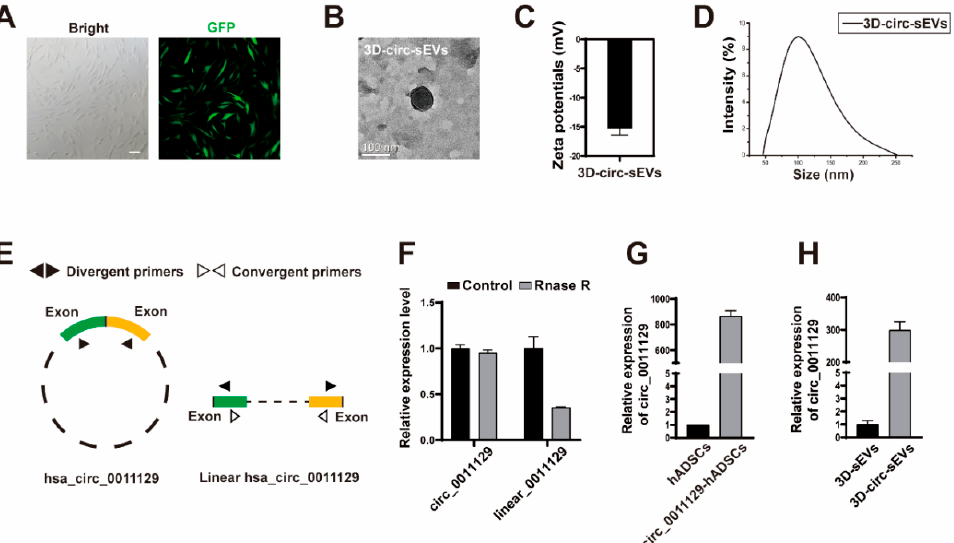
Figure 3. 3D-sEVs can carry circ_0011129 expressed by hADSCs. ( A ) Representative images of hADSCs expressing GFP (green) demonstrated that hADSCs expressed circ_0011129. Scale bar: 100 μΜ . ( B ) Representative TEM images of 3D-circ-sEVs. Scale bar: 100 nm. ( C , D ) The size distribution and Zeta potential of 3D-circ-sEVs were measured by DLS (n = 3). ( E ) The design ideas of divergent and convergent primers. ( F ) qRT-PCR analysis of circ_0011129 and linear_0011129 mRNA after RNase R digestion in hADSCs (n = 3). ( G ) qRT-PCR analysis of circ_0011129 relative expression between hADSCs and circ_0011129-hADSCs (n = 3). ( H ) qRT-PCR analysis of circ_0011129 relative expression between 3D-sEVs and 3D-circ-sEVs (n = 3). Error bar, mean ± SD.